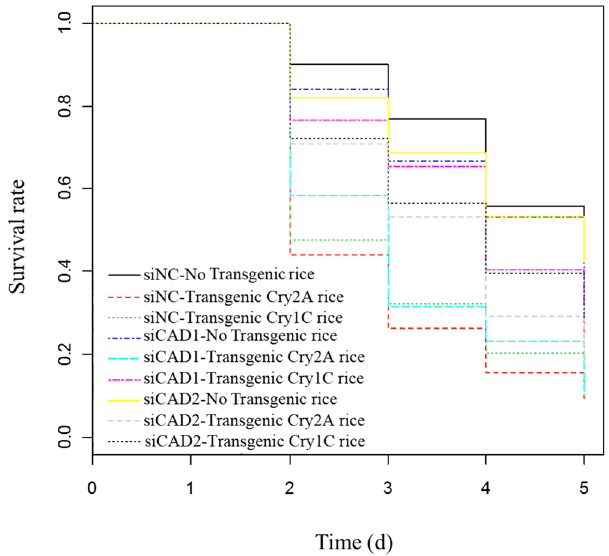
Figure 6. COX proportional hazard models for survival analysis; siNC-non-transgenic rice = negative control group feeding on non-transgenic rice, si CAD1 -non-transgenic rice = the CsCAD1 knockdown treatment group feeding on non-transgenic rice, si CAD2 -non-transgenic rice = the CsCAD2 knockdown treatment group feeding on non-transgenic rice, siNC-Transgenic Cry2A rice = the negative control group feeding on transgenic rice expressing Cry2A; si CAD1 -Transgenic Cry2A rice = the CsCAD1 knockdown group feeding on rice expressing Cry2A; si CAD2 -Transgenic Cry2A rice = the CsCAD2 knockdown treatment group feeding on transgenic rice expressing Cry2A, siNC-Transgenic Cry1C rice = negative control group feeding on transgenic feeding on transgenic rice expressing